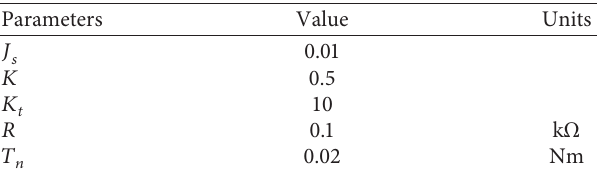
Table 2: The parameters of the ventilator motor in D-Q coordinates.